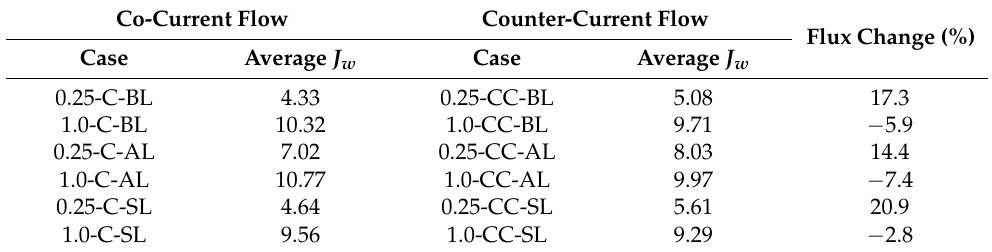
Table 6. Effects of flow configuration on the average water flux (L/m 2 · h) using MgCl 2 draw